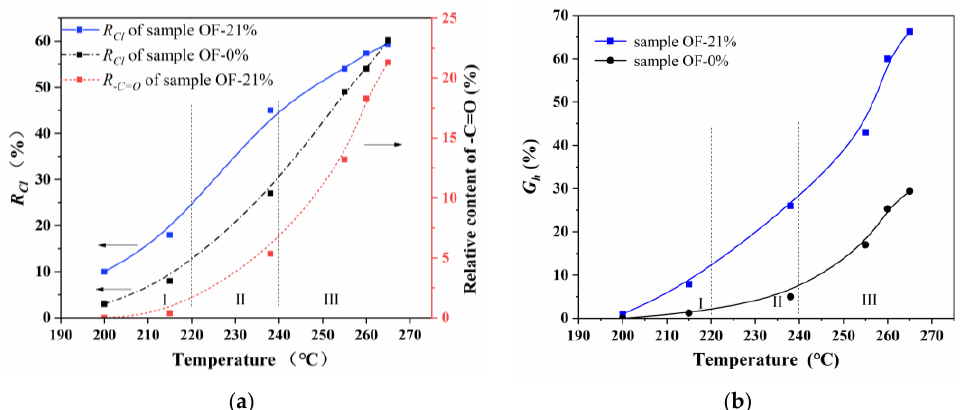
Figure 5. The 13 C-NMR characterization of chemical structure evolution of pre-oxidized fibers of ( a ) R Cl and ( b ) G h